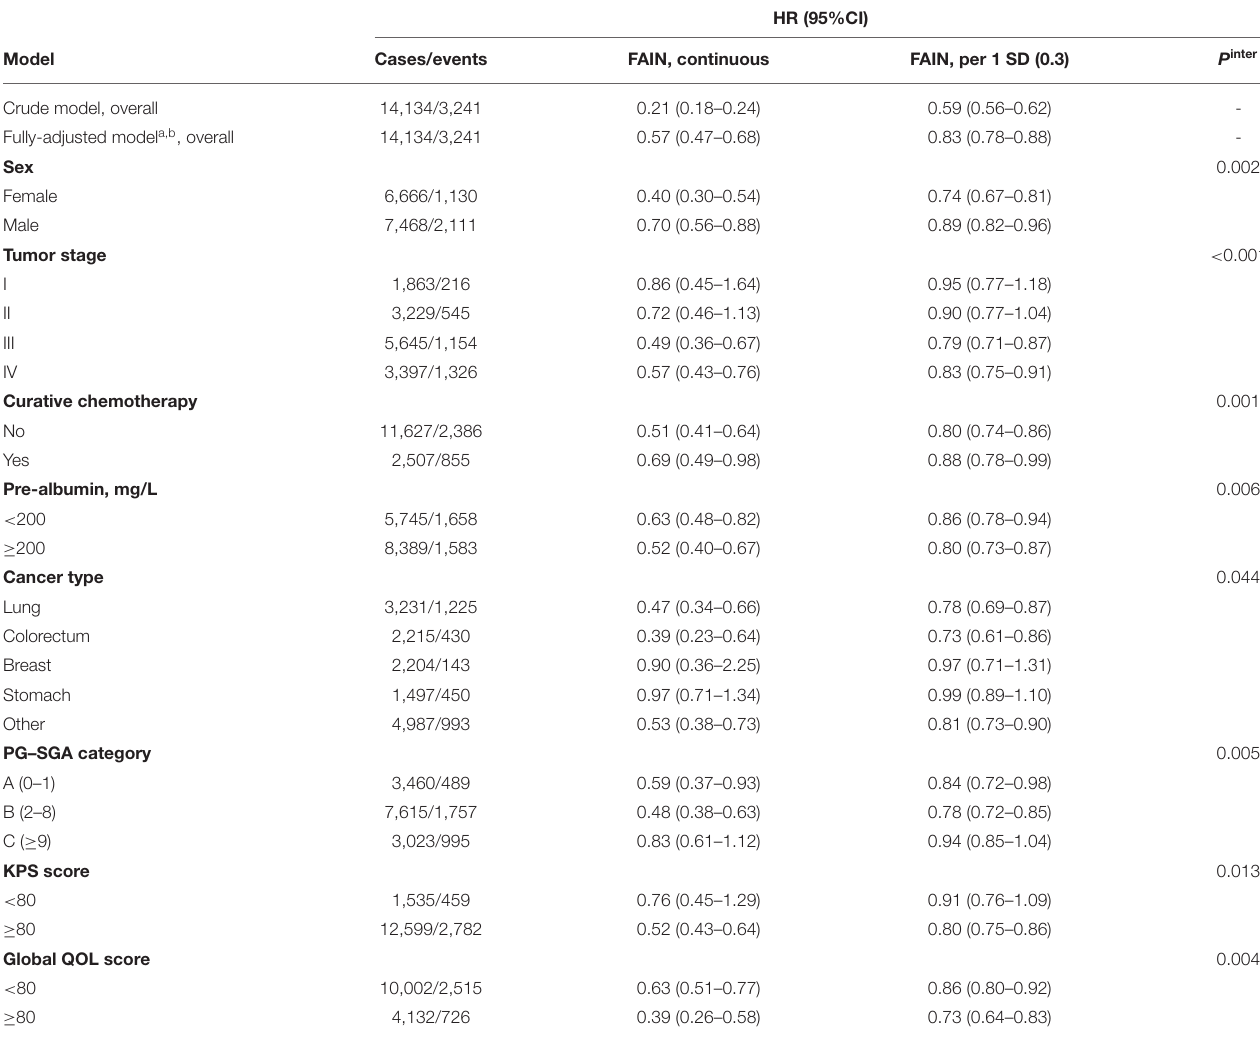
TABLE 4 | Multivariable models stratified by factors showing interactive effects with the